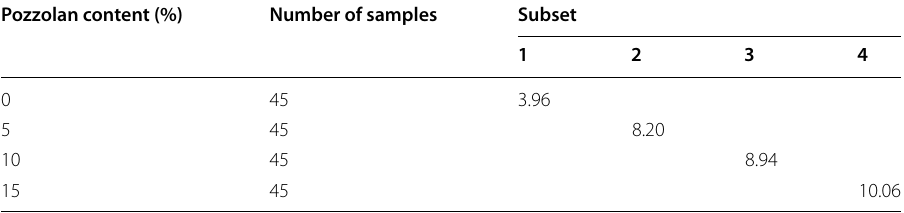
Table 7 Effect of pozzolan content on mean of compressive strength of treatments Pozzolan content (%)